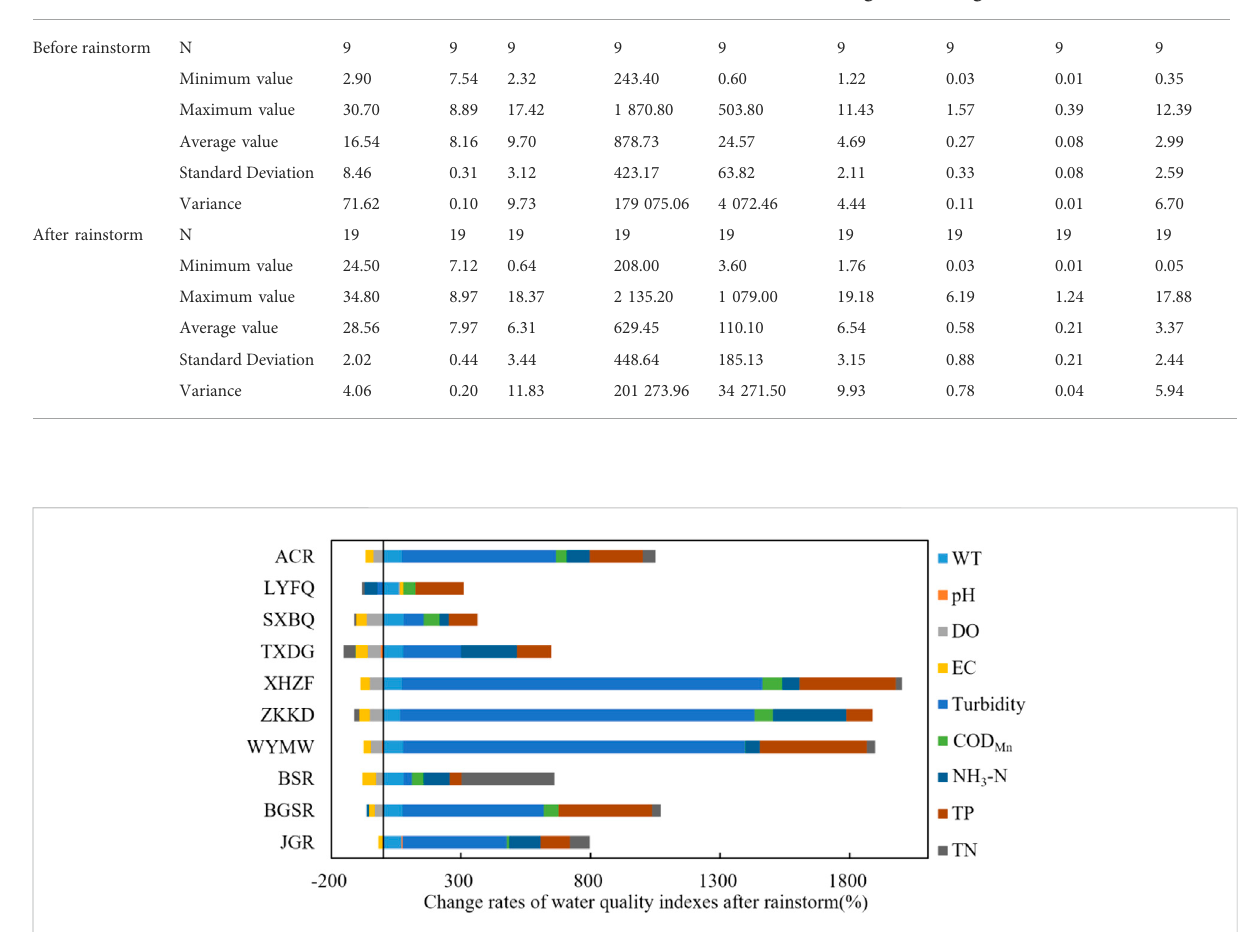
FIGURE 3 The changing rates of water quality indicators at each monitoring section before and after the